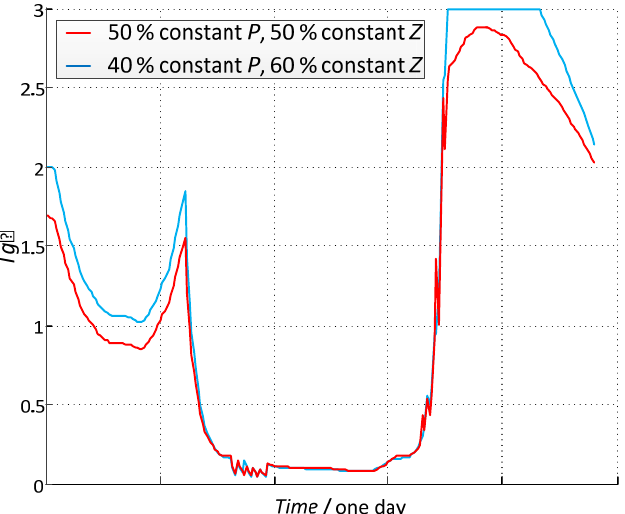
Figure 15. Desired optimal tg φ using different load